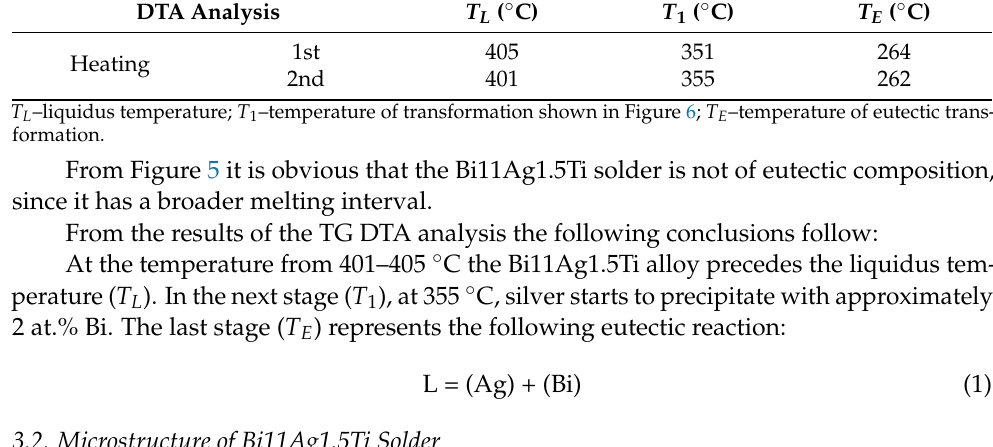
Figure 8. Point EDX analysis of Bi11Ag1.5Ti solder.